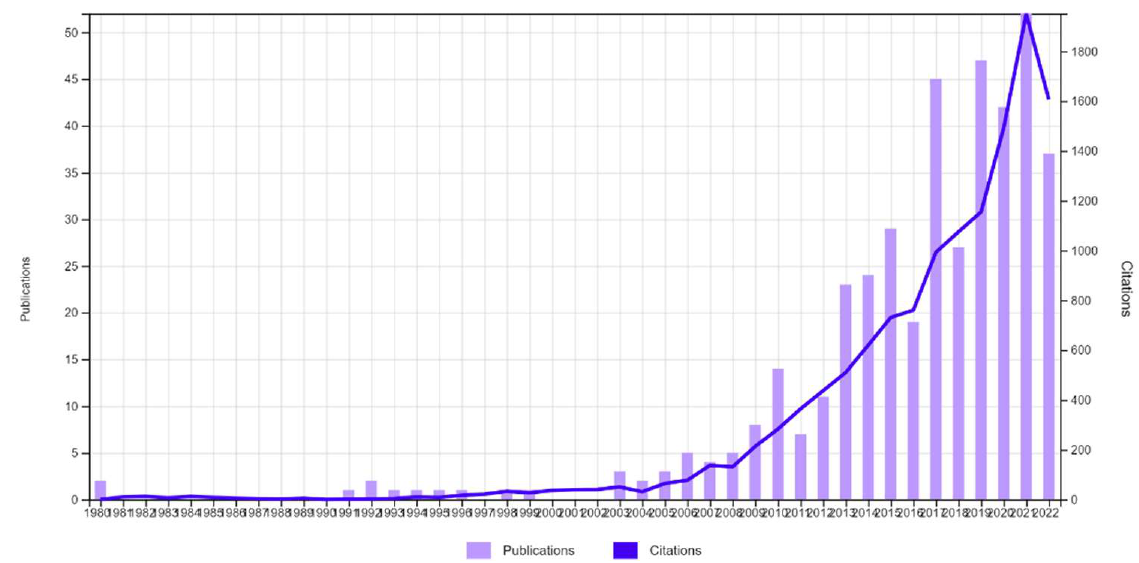
Figure 2. The number of relevant publications and citations [WoS Citation Report: photocat* (Topic) AND “strontium titanate” (All Fields)].